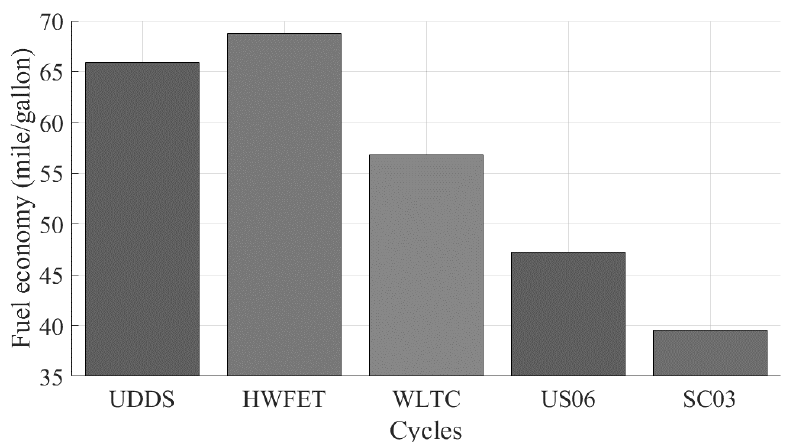
Figure 4. Fuel Economy according to Cycles with Hot Test: Urban Dynamometer Driving Schedule (UDDS), Highway Fuel Economy Test (HWFET), Worldwide Harmonized Light Vehicles Test Cycles (WLTC), High Acceleration Aggressive Driving Schedule (US06), Use of Air Conditioning Driving Schedule (SC03).